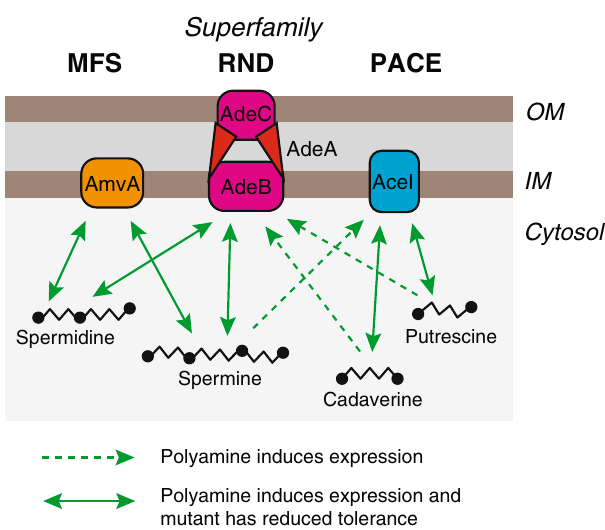
Fig. 5 Schematic of known links between polyamines and ef fl ux pumps in A. baumannii . AmvA, AdeABC and AceI of the MFS, RND and PACE ef fl ux pump families are each induced by, and confer tolerance to, distinct subsets of the four major biological